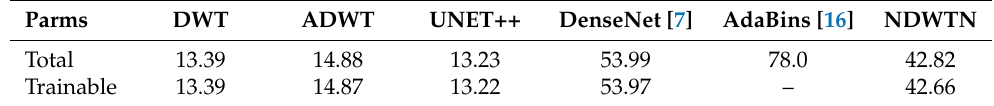
Table 1. Parameters and models (in